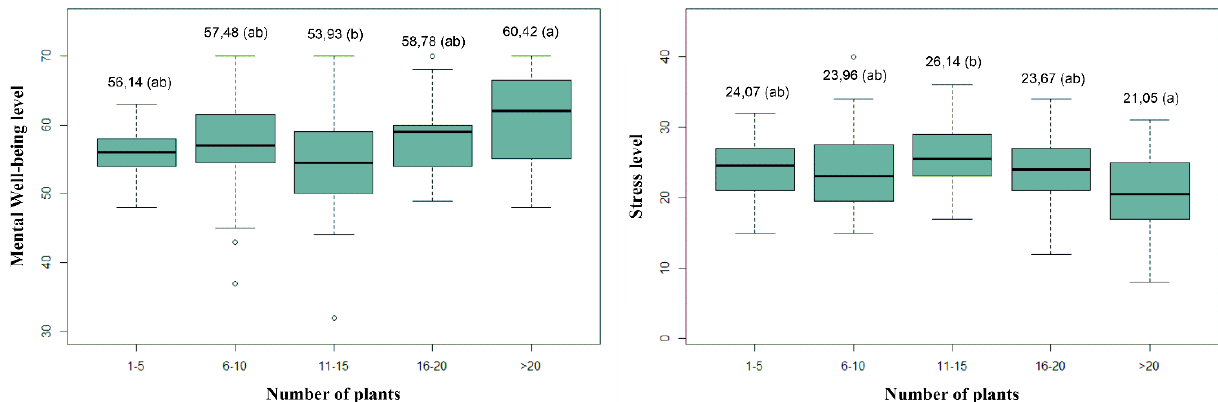
Figure 11 . Box plot with the average factor of plant number related to the level of mental well-being (left) and level of stress